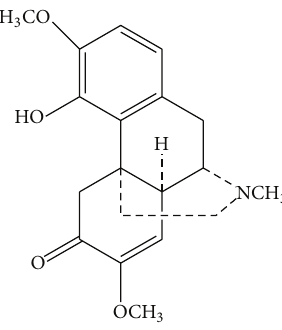
Figure 1: The structure of sinomenine.